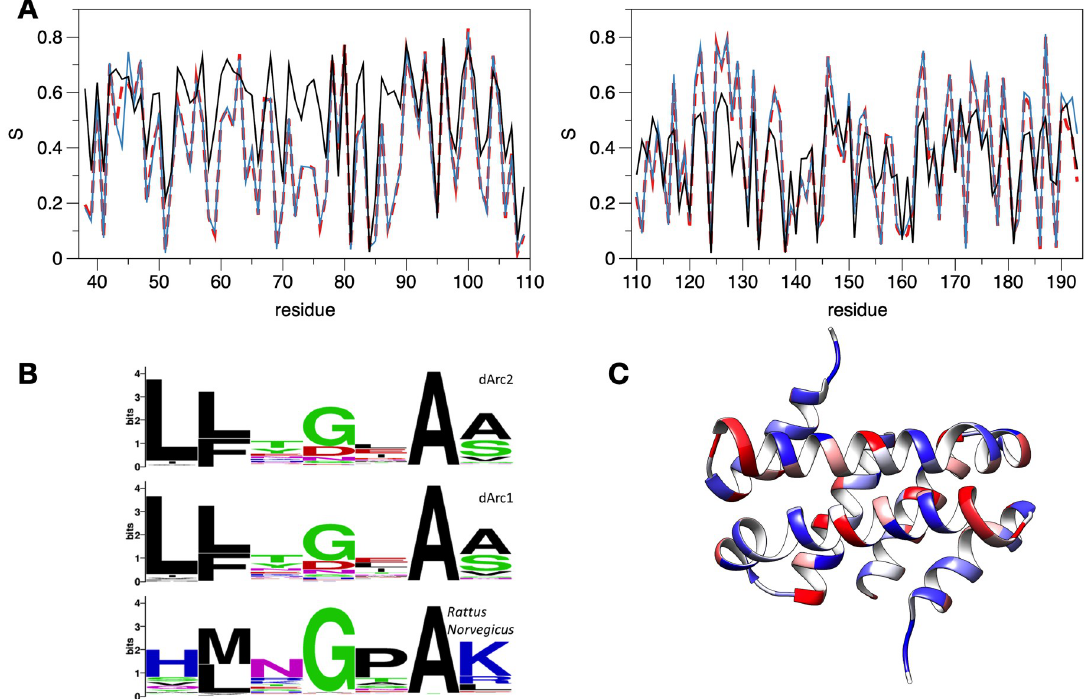
Fig 5. Sequence conservation analysis of the central lobe region. (A) Sequence variability in Arc N- and C-lobes (left and right, respectively). S is sequence entropy / variability within the seach results at each position (see Methods for details). Numbering follows dArc2. Red dashed lines: a search with dArc2 gave 220 homologues. Blue: a search with dArc1 and dArc2 resulted in a combined group of 250 homologues. Black: 699 sequences resulting from a search with dArc1, dArc2, and rat Arc. (B) Sequence logo for the region centered at Ser79 of dArc2-NL compared to corresponding residues from dArc1 and Rattus norvegicus homologues. While Gly is the most conserved residue at this position, starting searches with dArc1 and dArc2 indicates variability also at this position, unlike a search with rat Arc. (C) Mapping of conservation onto the dArc2-NL dimer. Blue corresponds to conserved and red to non-conserved sites.